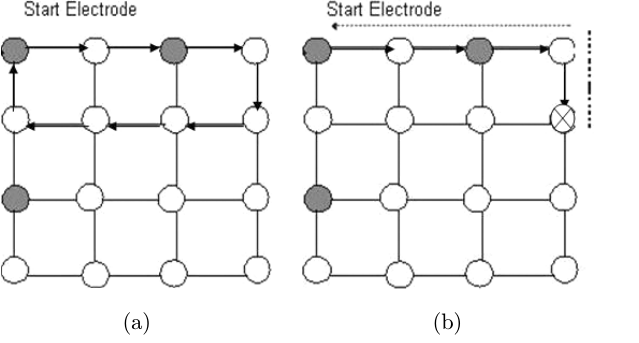
Fig. 6. Clockwise movement of droplet in microarray with a fault-free and a faulty loop and anticlockwise backtrack.